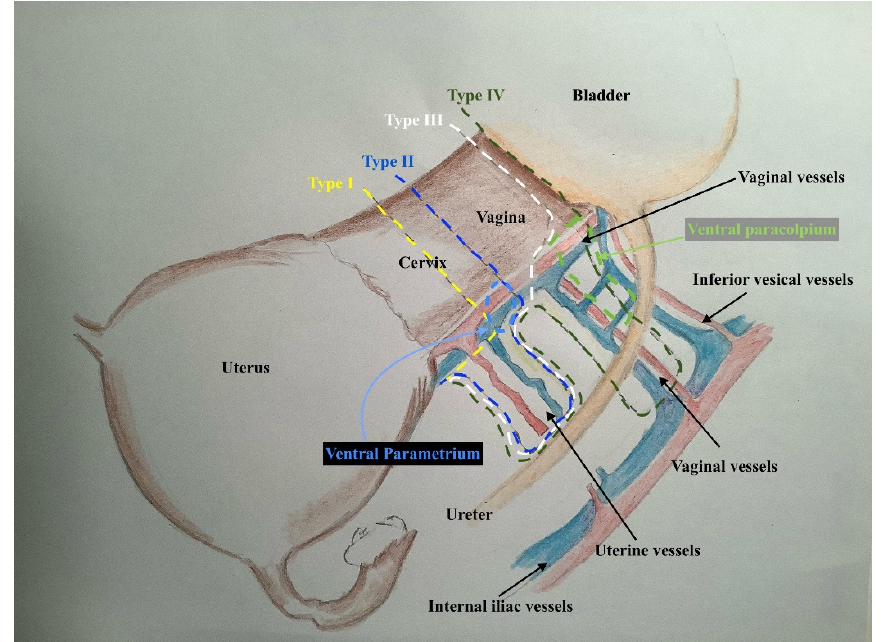
Figure 9. The graphic explanation of the type IV radical hysterectomy according to Muallem classi- fication; the dotted green line shows the resection line at the distal aspects of ventral, lateral and dorsal parametrium and at the distal aspects of ventral, lateral and dorsal paracolpium.